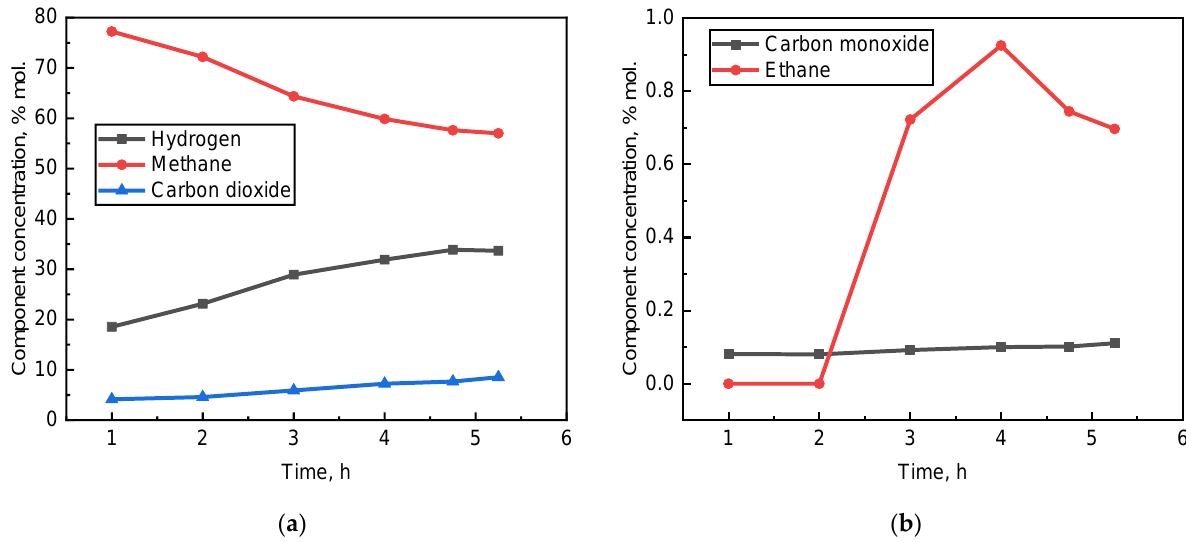
Figure 5. ( a ) The dependencies of major gas component concentrations and ( b ) minor gas component concentrations in product gas mixture in experiment No. 3 on time.